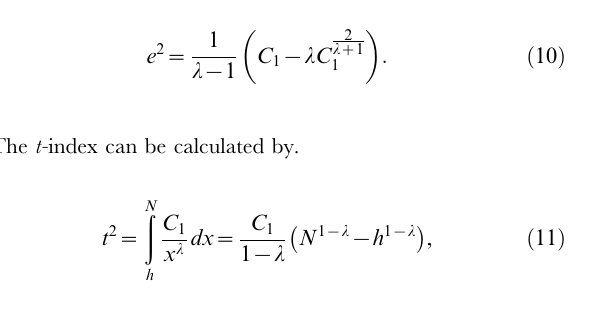
Table 2. The top ten prolific economists based on different evaluation indices.